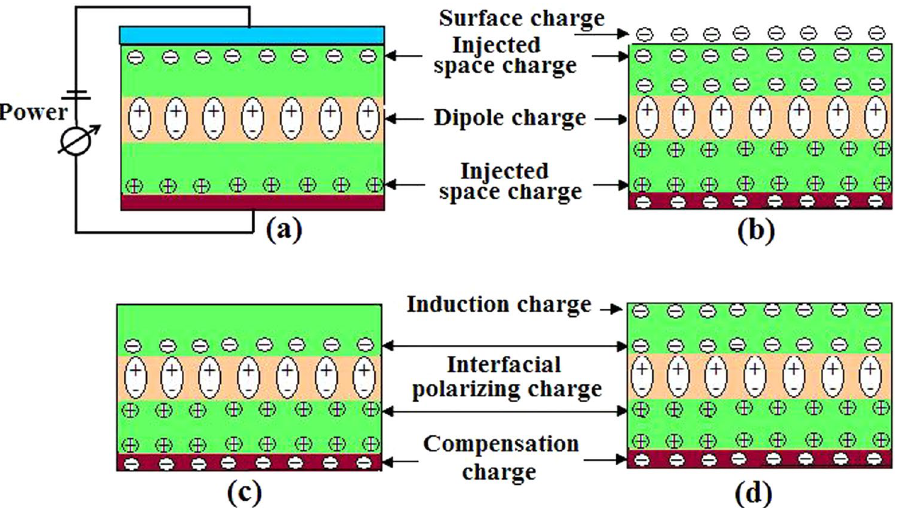
Figure 2. Charge producing and stabilizing mechanism analysis of PTFE/THV/PTFE electret membrane. ( a ) Configuration and charge profile when membrane is charged. ( b ) Charge profile of original sample after electric field is removed. ( c ) Charge profile after surface is cleared with alcohol. ( d ) Charge profile of wiped sample after induction charge is